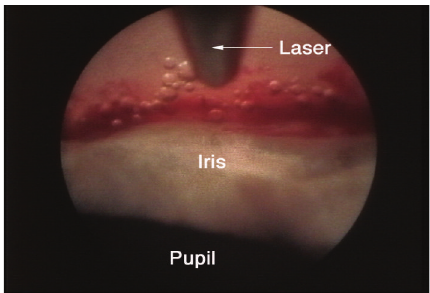
Figure 3: Refluxed blood and bubble formation represent successful photoablation (courtesy of J. Funk, MD,